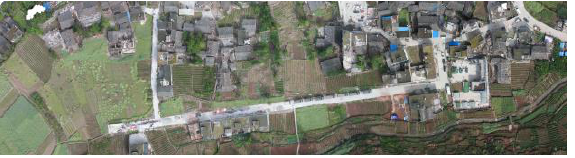
Figure 8. The experimental dataset (3845 × 1038)